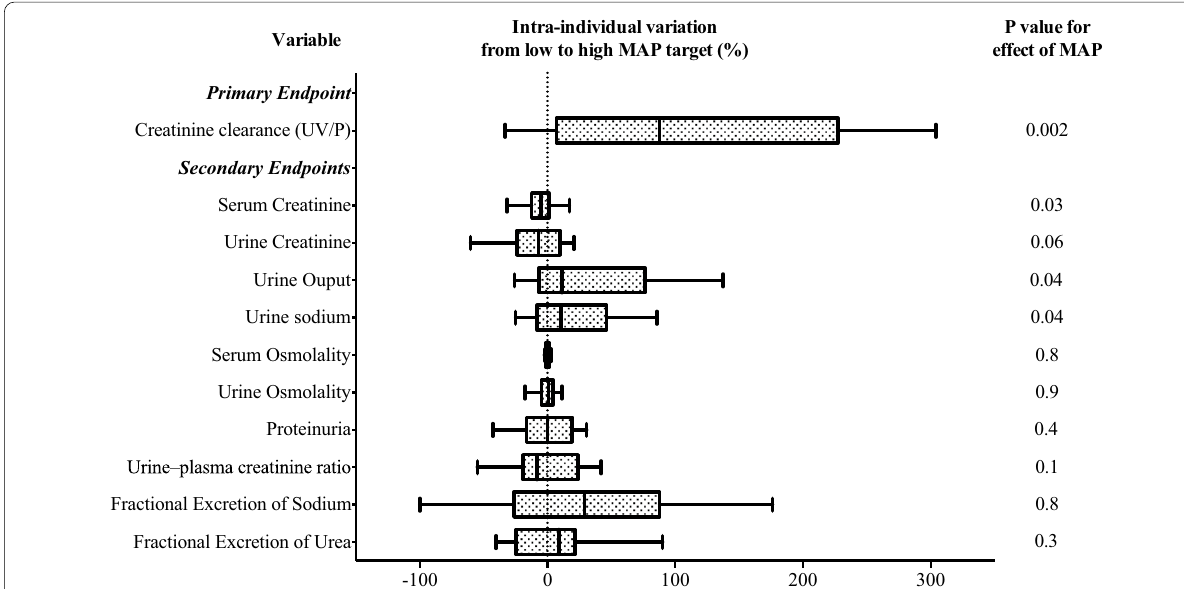
Data are expressed as the mean (SD) and mean individual difference (IC95%) from low- to high-MAP target period P values for the within-subject comparisons between the low and the high-MAP target period a multivariate repeated-measures analysis of variance (MANOVA) including the order of assignment of MAP regimes and the KDIGO stage at inclusion as factors a Calculated using the UV/P formula MAP: mean arterial pressure; KeGFR: kinetic estimated glomerular filtration rate